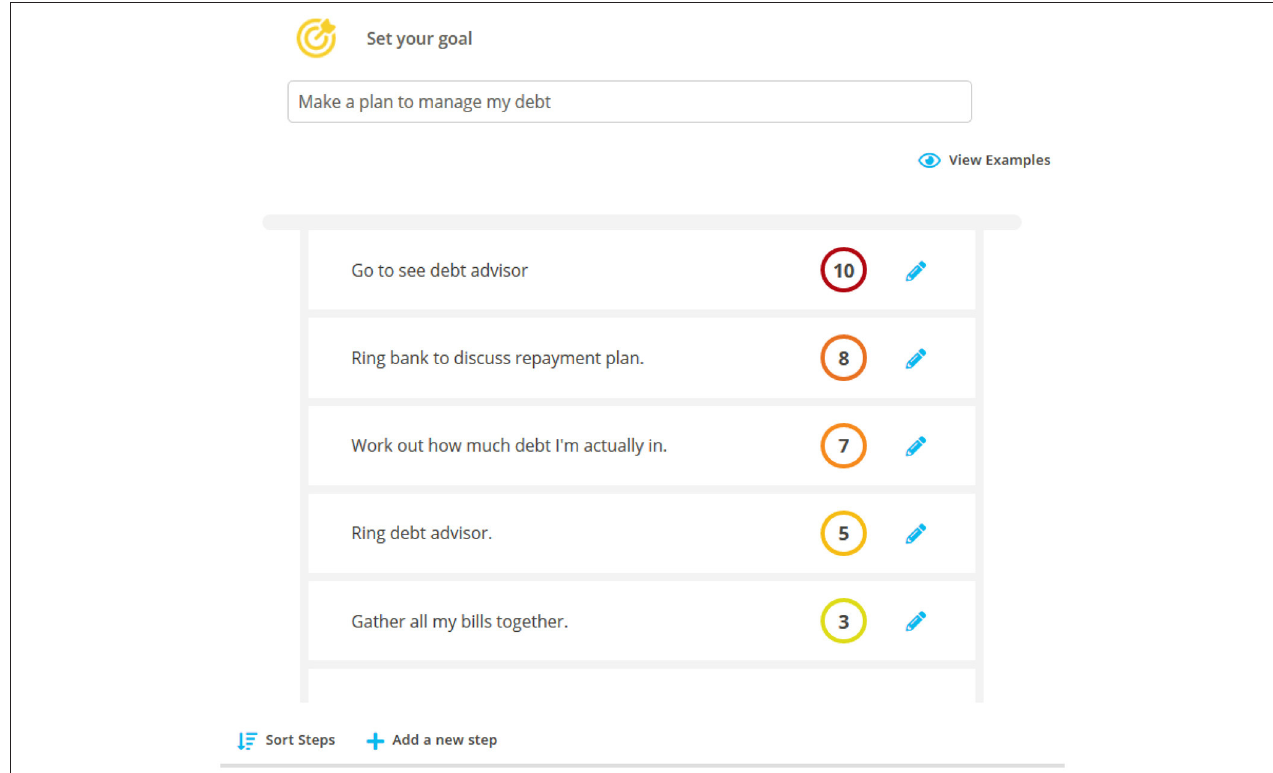
FIGURE 1 | A screenshot from space from money worries: the ‘facing my financial fears’ hierarchy.